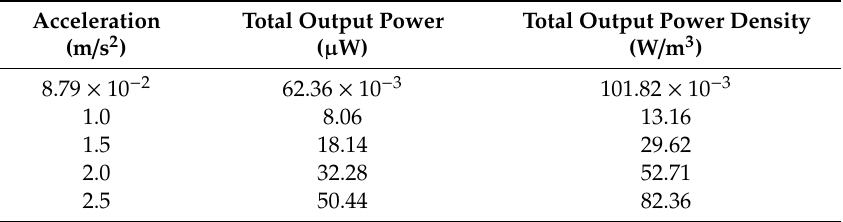
Figure 12. Maximum output power of the nanogenerator regarding four different accelerations in y -direction and a frequency range from 117 to 120 Hz. Table 5. Total output power and power density of the nanogenerator under di ff erent accelerations in y -direction.